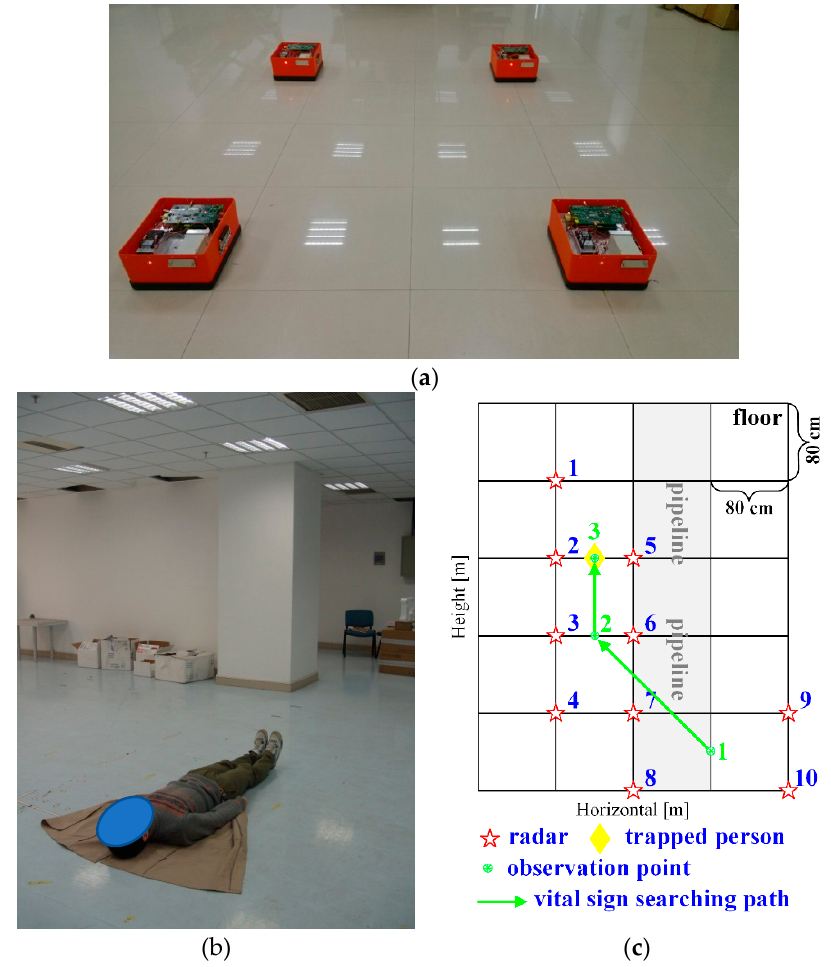
Figure 8. The experimental setup. ( a ) The four wireless-netted UWB life-detection radars deployed on a floor; ( b ) the human test subject acting as a trapped person; ( c ) the top view of the 2D observation aperture and the vital sign searching path.